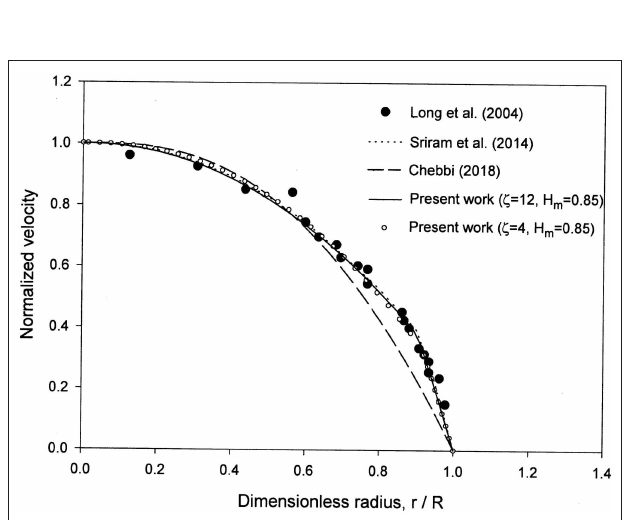
FIGURE 2 | Comparison of the present model with the numerical results in Sriram et al. [ 12] and the experimental data in Reinke et al. [30], Pries et al. [ 31], and Suzuki et al. [32] reported in Sriram et al. [12] for the normalized velocity profile for H D = 0.335 and R = 27.1 µ m.